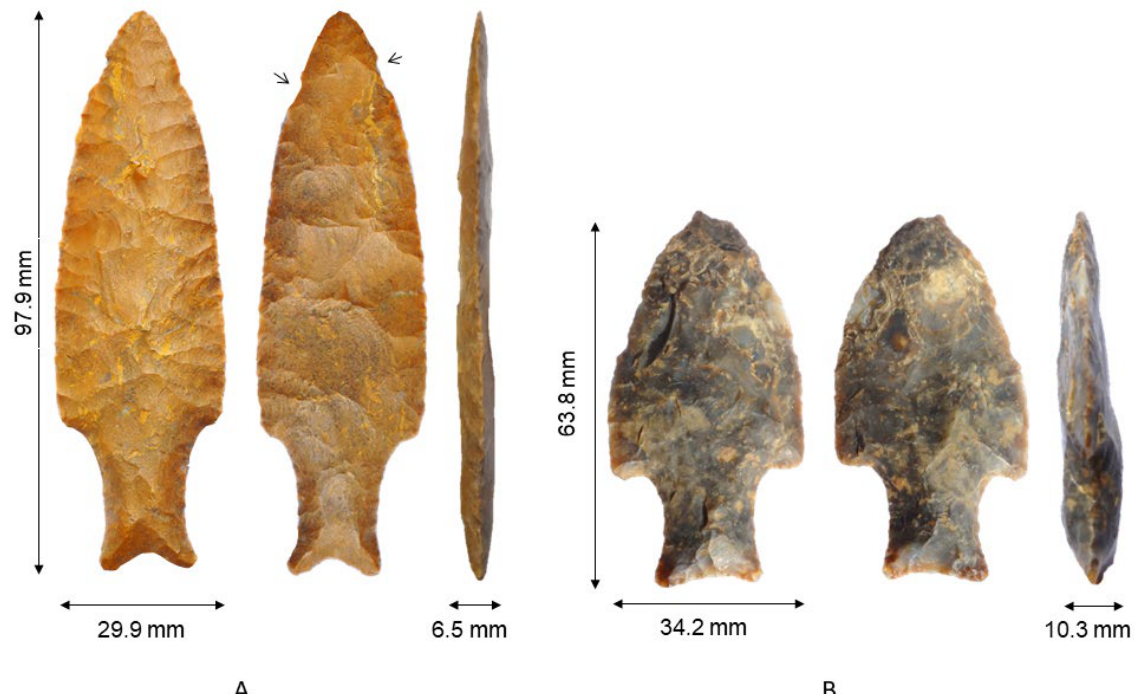
Figure 2. Piece A: FP recovered on the surface at Urupema County, and currently curated at the Museu Histórico Thiago de Castro, Lages, Santa Catarina. B: FP collected on the surface at Painel County, Santa Catarina. Private